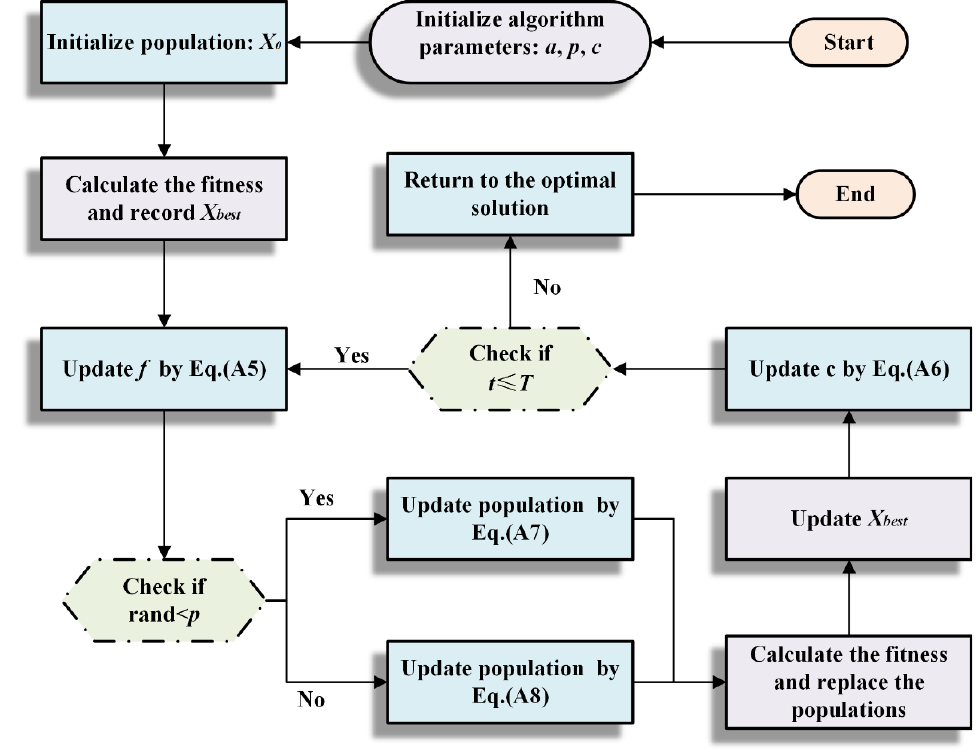
Figure A1. Flowchart of BOA.